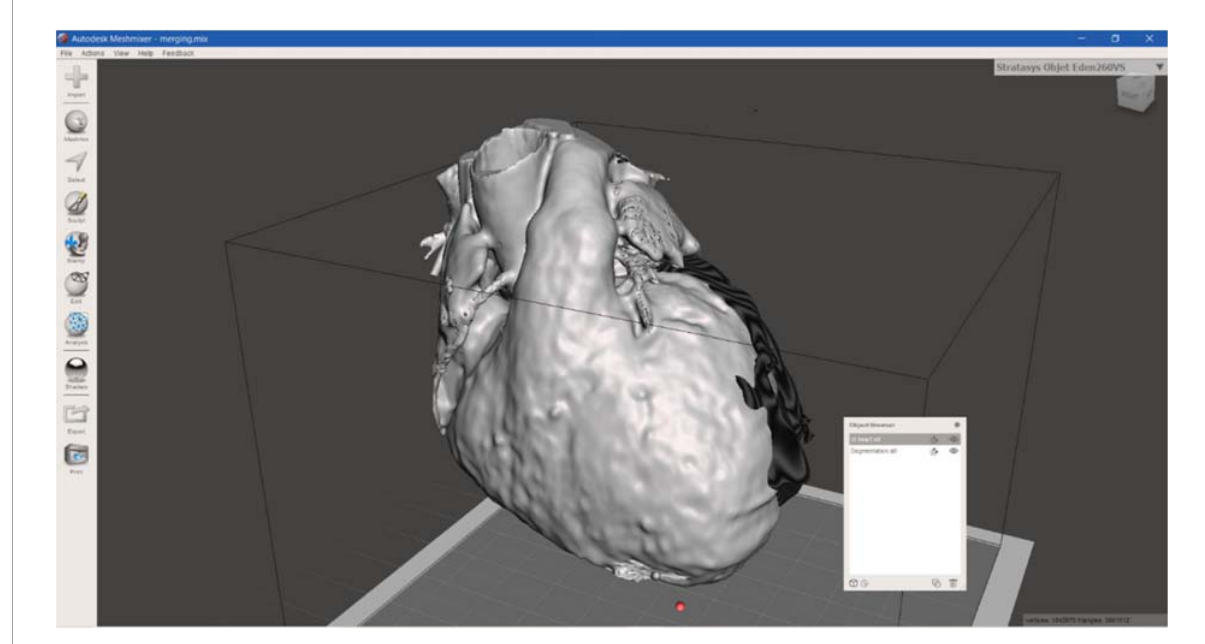
FIGURE5 3D models merging. CT and CMRI models merging on the Autodesk Meshmixer software.